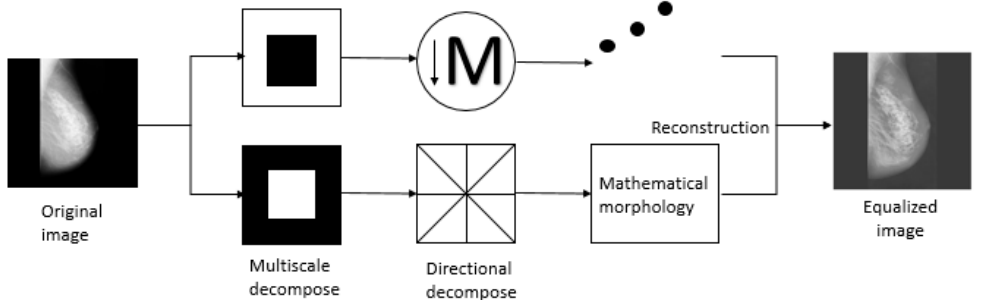
Figure 2. Contourlet transformation and morphology (CTM).